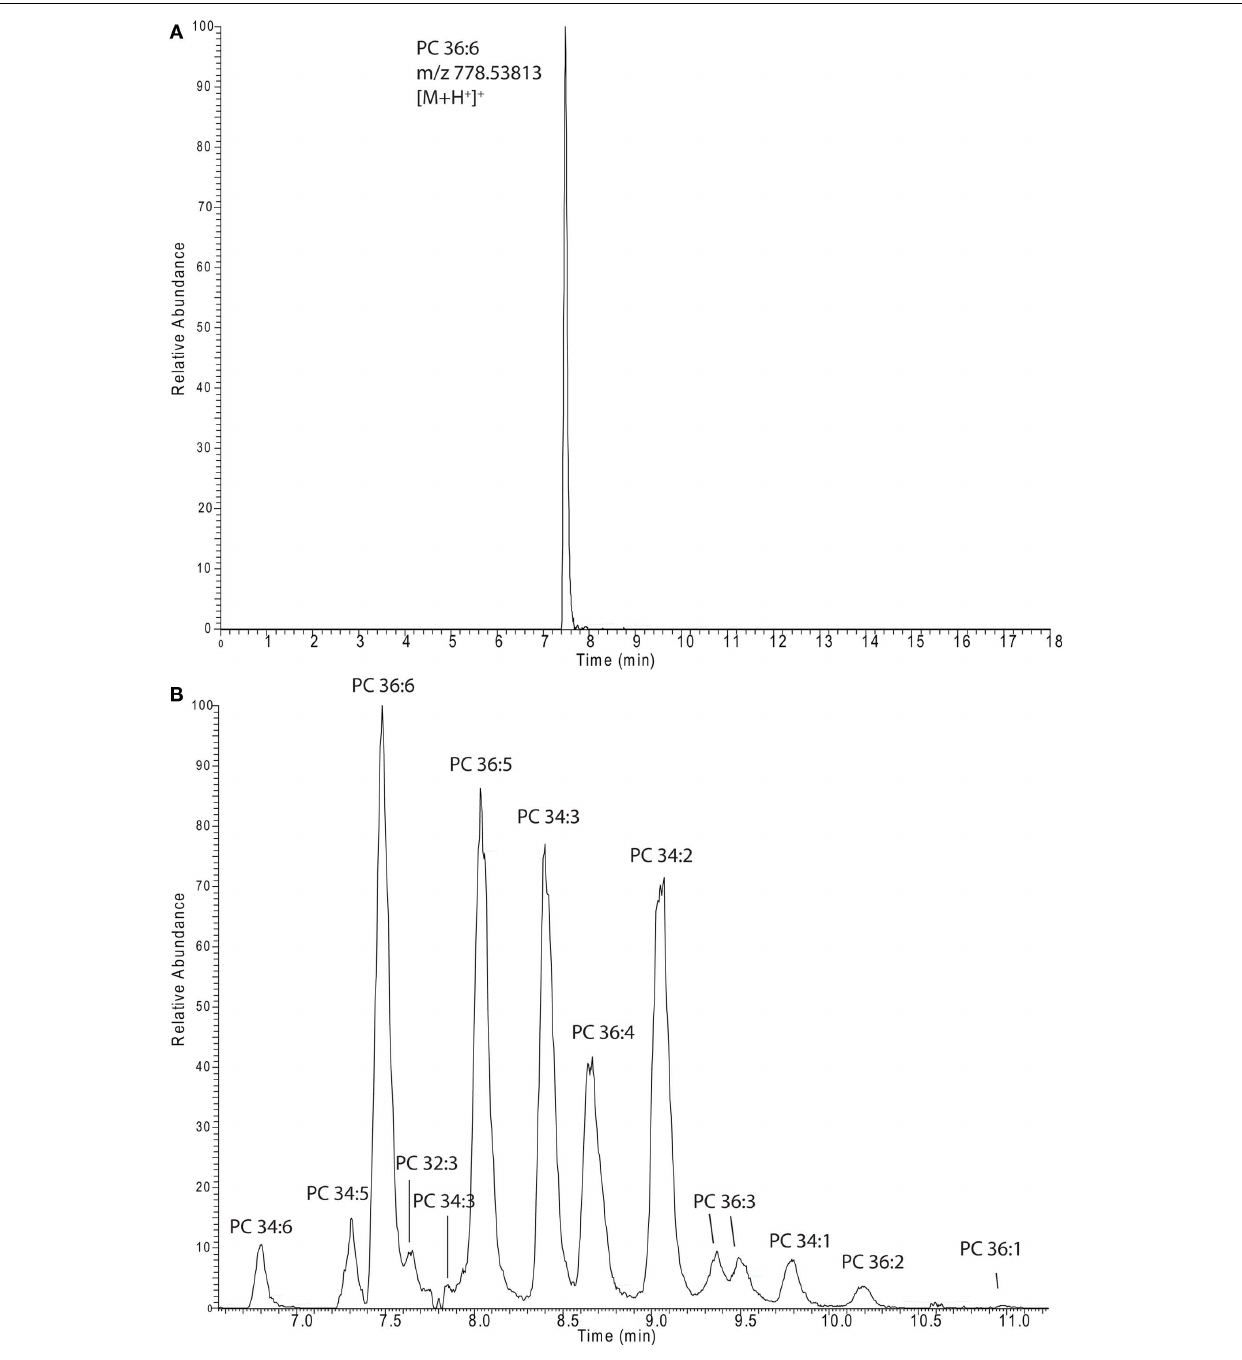
unchargedfragment(neutralloss).Thistechniquecanalsobeused on LC–MS-based systems in non-shotgun lipidomic studies,